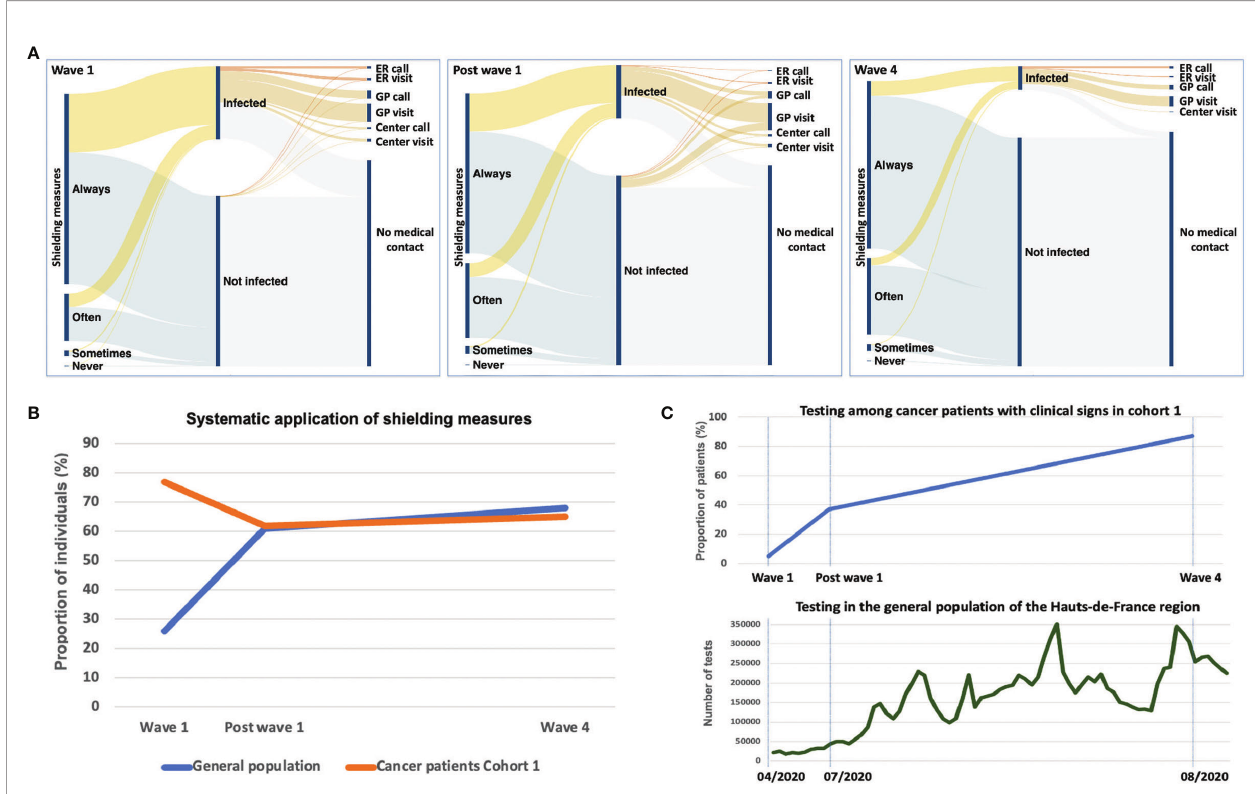
FIGURE 2 | Patients ’ behavior toward COVID-19 infection. (A) Sankey diagrams of patients ’ application of shielding measures during the pandemic (cohort 1), and of the medical care sought by infected patients (experiencing COVID-19-like symptoms) and asymptomatic patients. (B) Systematic application of shielding measures in the general population of the Hauts-de-France region (blue line) and among cancer patients (cohort 1, orange line) during the pandemic. The systematic wear of the mask was the indicator used for the general population using the French GEODE database. Among cancer patients, the systematic application of fi ve shielding measures globally (wearing a mask, avoiding gatherings, hand washing, physical distance, coughing in the elbow) was indicated. (C) Testing among cancer patients in cohort 1 (upper graph) and the general population of the French Hauts-de-France region (lower graph). The proportion of cancer patients with clinical symptoms of COVID-19 infection tested for COVID is indicated per wave. The trend of testing in the general population of the same region is indicated as the number of weekly tests during the pandemic. ER, emergency room; GP, general practitioner; Center, Oscar Lambret cancer